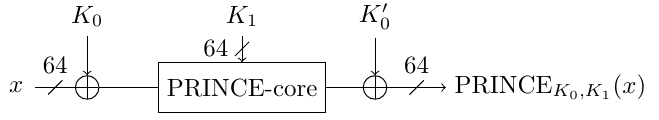
Figure 5: The PRINCE cipher. K 0